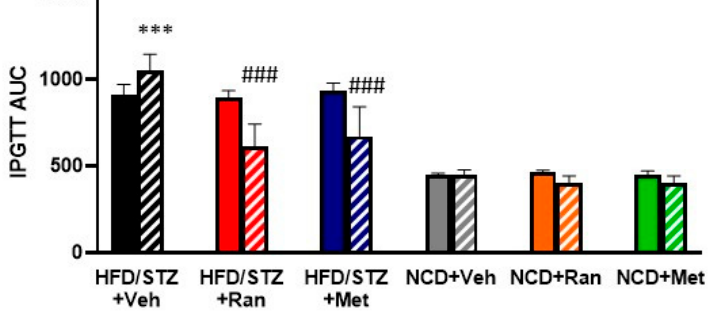
Figure 2. Area under the curve (AUC) during a 120 min IPGTT at baseline (full bars) and after 8 weeks (striped bars) of treatment. Values are expressed as mean ± SD; *** p < 0.0001 significantly different from NCD + Vehicle group, ### p < 0.0001 significantly different from HFD/STZ + Vehicle group by two-way ANOVA with Tukey’ s post hoc test. AUC = Area under curve; HFD = High fat diet; NCD = Normocaloric diet; STZ = Streptozotocin; Veh = Vehicle; Ran = Ranolazine; Met = Metformin. 0.011 NCD 0.0002 met.